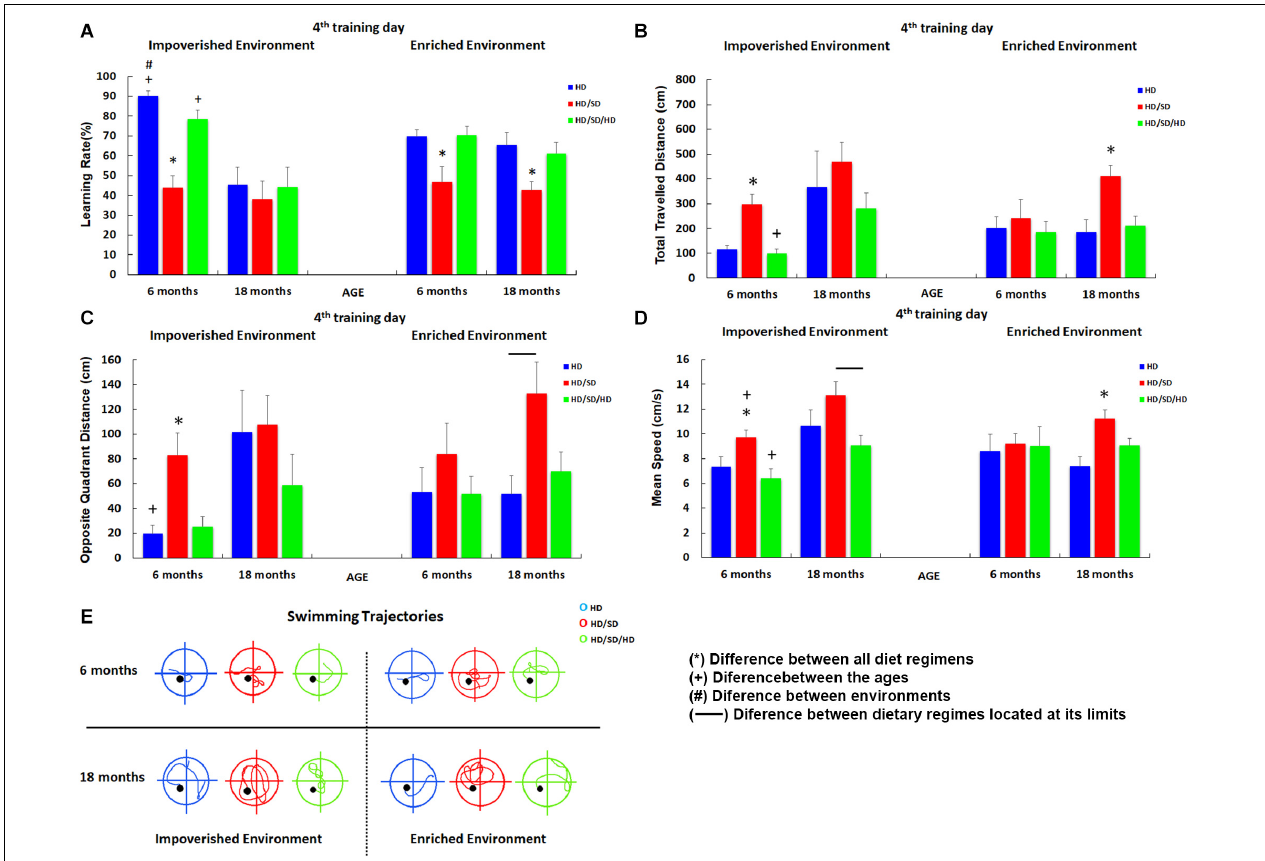
FIGURE 3 | Influence of environment (impoverished and enriched), age (6 and 18-month-old) and diet regimens (HD, HD/SD, and HD/SD/HD) in the learning rates by the Morris Water Maze protocol at the 4th testing day. (A) Learning rates in percentage (%) for each experimental group. (B) Total distance (cm) traveled by each experimental group. (C) Distance (cm) traveled in the opposite quadrant of the platform. (D) Swimming speed (cm/s). (E) Swimming trajectories representative of each group. Trajectories correspond to the average distance closer to that of the group. Results are expressed as mean ± standard error. (*) Significant differences between all diet regimes; connector lines indicate significant differences between dietary regimes; (+) Significant differences between ages; (#) significant differences between environments. HD, hard diet/pellet food and SD, soft diet/powder